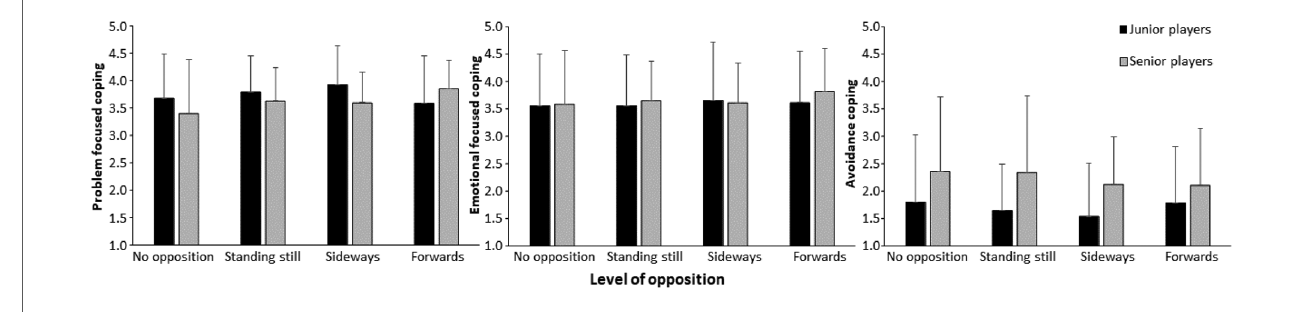
FIGURE 4 Average (±SD) c oping strategies for each condition for each group.